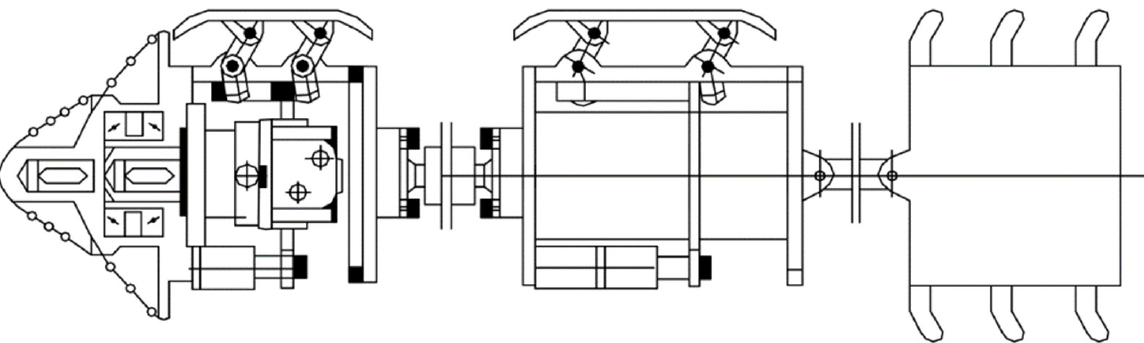
Figure 8. Pipeline dredging robot.